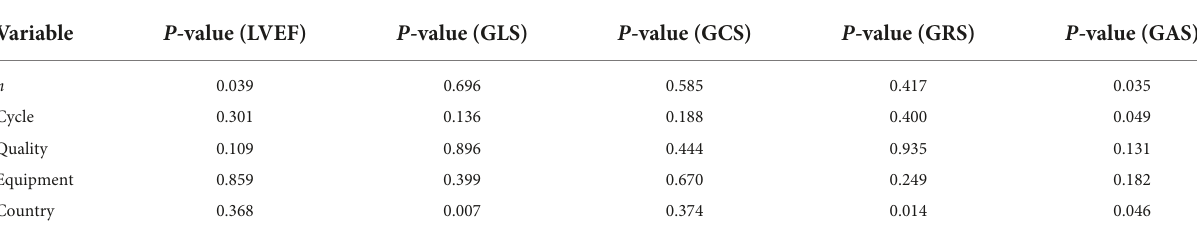
TABLE 2 Strain parameter of meta regression analysis